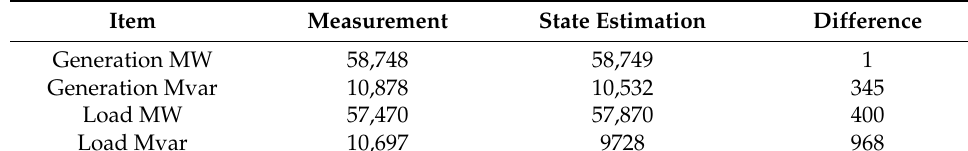
Table 15. Comparison between the measurements and the state estimation.